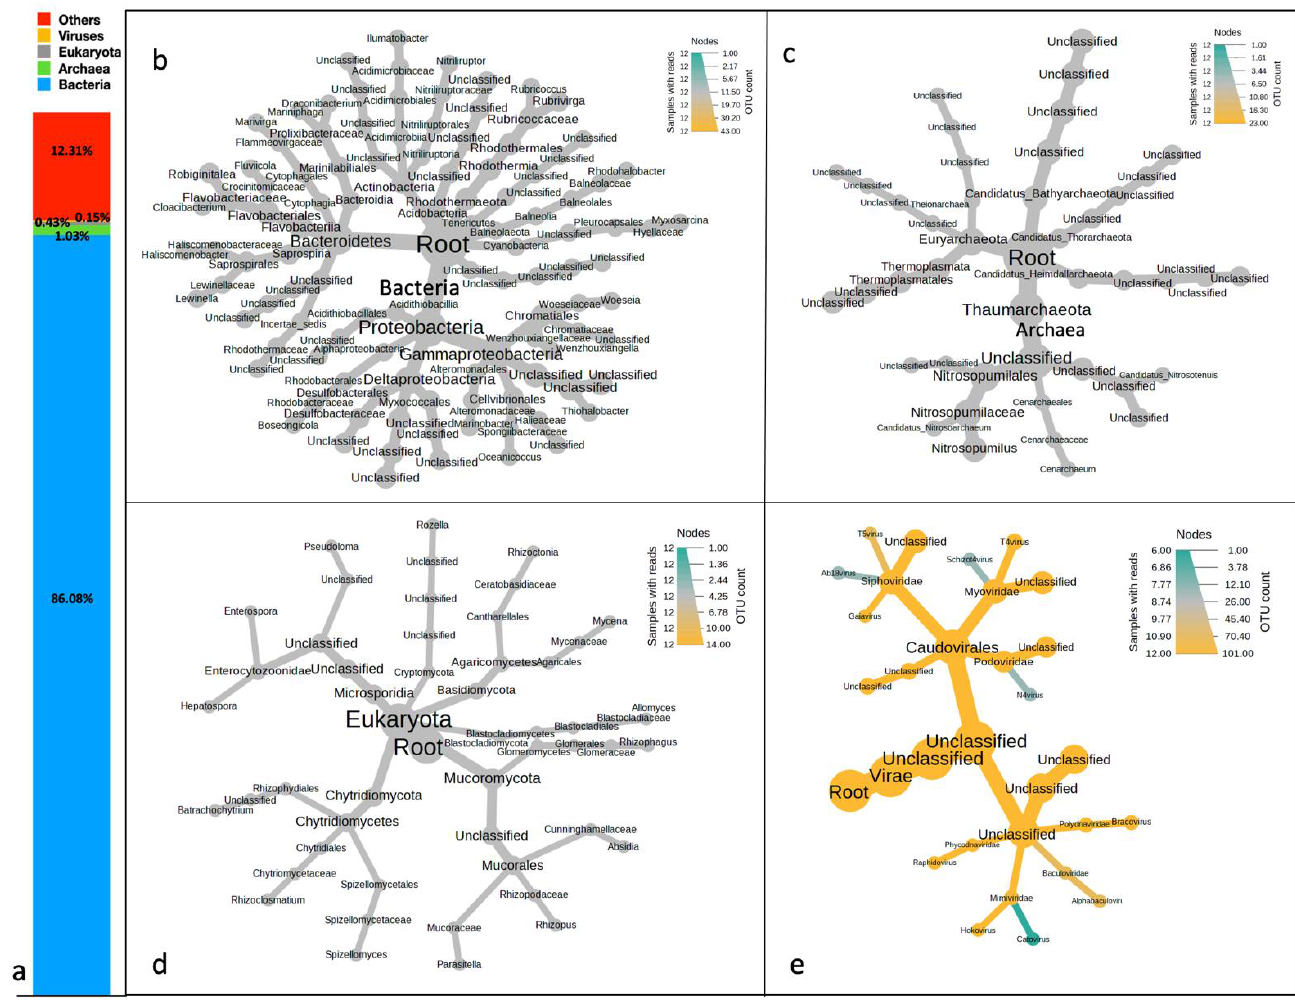
Figure 3. ( a ) Domain-level classification of microbial communities of marine sediments of Kuwait. Taxonomic profiles of ( b ) bacterial, ( c ) archaeal, ( d ) eukaryotic, and ( e ) Viral domains distributed across the marine sediments of Kuwait. Heat trees were created on median abundance by applying Wilcoxson’s sum test at a p -value less than 0.05.